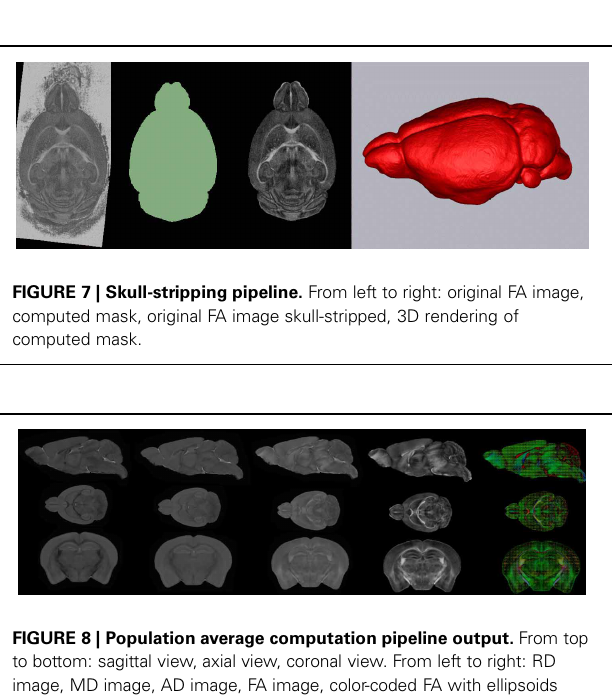
FIGURE 6 | Rigid registration pipeline. The DWI scan is registered to a template and derived images (MD, FA, b = 0, iDWI, color-coded FA) are computed.